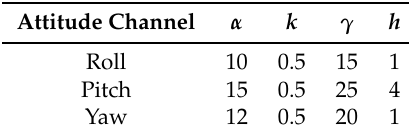
Table 3. Simulation parameters in Equations (27) and (28).